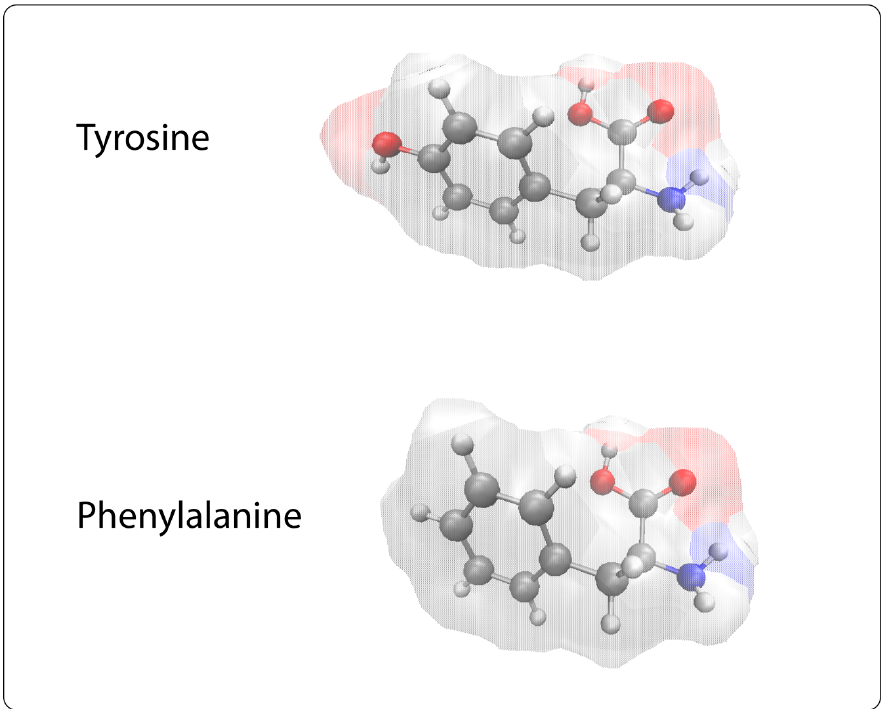
Figure 10. The absence of the phenolic hydroxyl group in Phe is responsible for the different biological properties between the two synthetic analogues MBP 83–99 (Tyr 91 ) and MBP 83–99 (Phe 91 ).